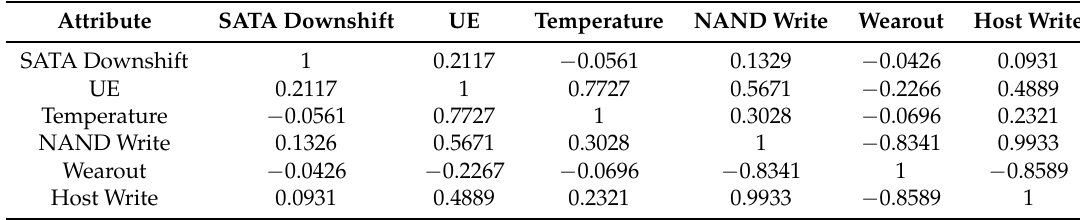
Table 8. Pearson Correlation Coefficient.